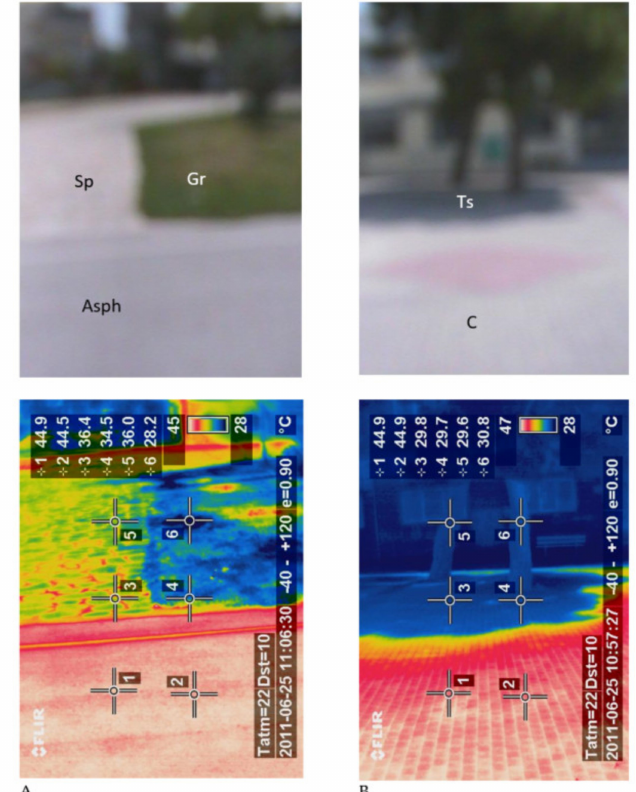
Figure 3. Surface temperatures of ( A ) ground covering materials with di ff erent properties and ( B ) ground under the tree shade or exposed to sun. Sp: Schistolithus plates; Gr: Grass; Asph: Asphalt; C: Pavers; Ts: Tree